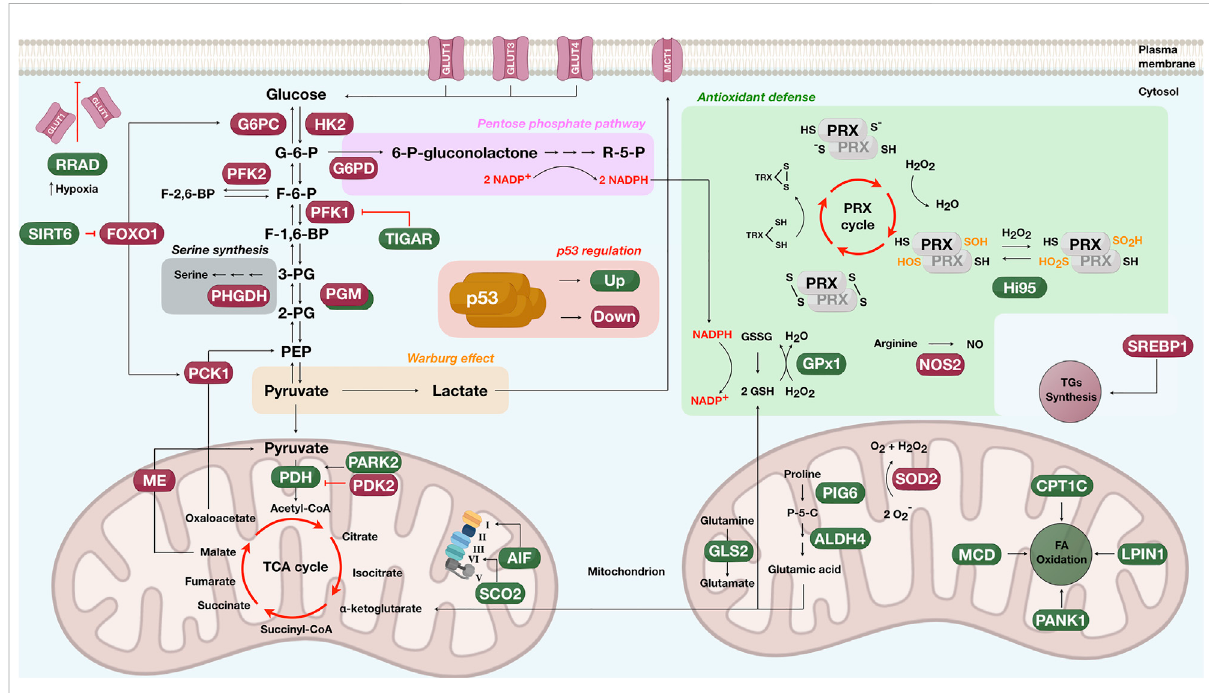
FIGURE 4 Schematics showing the participative role of p53 in metabolic pathways such as the glycolysis (glucose to pyruvate), the oxidative phosphorylation (left mitochondrion), the pentose phosphate (pink rectangle), the Warburg effect (orange rectangle), the serine synthesis (gray rectangle), proline and glutamine degradation (right mitochondrion), the antioxidant defense (green box), the fatty acid (FA) oxidation (right mitochondrion), and triglycerides (TGs) synthesis (cytosol). Proteins upregulated by p53 are shown in green and downregulated in dark red. G- 6-P, glucose-6-phosphate; F-6-P, fructose-6-phosphate; F-1,6-BP, fructose-1,6-biphosphate; F-2,6-BP, fructose-2,6-biphosphate; 3-PG, 3- phosphoglycerate; 2-PG, 2-phosphoglycerate; PEP, phosphoenolpyruvate; R-5-P, ribose-5-phosphate; P-5-C, pyrroline-5-carboxylate; TCA, tricarboxylic acid; PRX, peroxiredoxins; TRX, thioredoxin; GSH, glutathione; GSSG, oxidized glutathione; -SH, sulfhydryl group; S-S, oxidized sulfhydryl (disul fi des); NO, nitric oxide; -SOH, sulfenic acid; -SO 2 H, sul fi nyl group; O 2 − , superoxide radical; H 2 O 2 , hydrogen peroxide; NADP+, nicotinamide adenine dinucleotide phosphate; NADPH, reduced form of nicotinamide adenine dinucleotide phosphate. For protein names controlled by p53, please check in-text